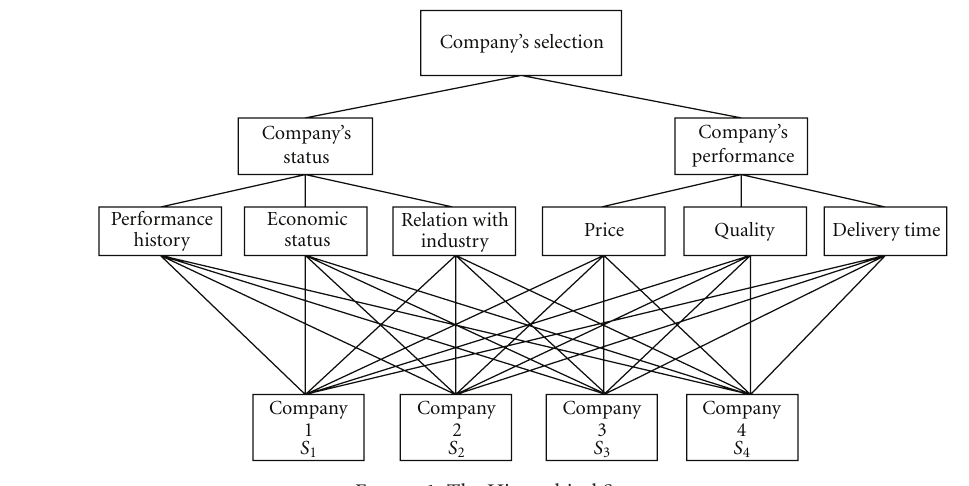
Figure 1: The Hierarchical Structure.